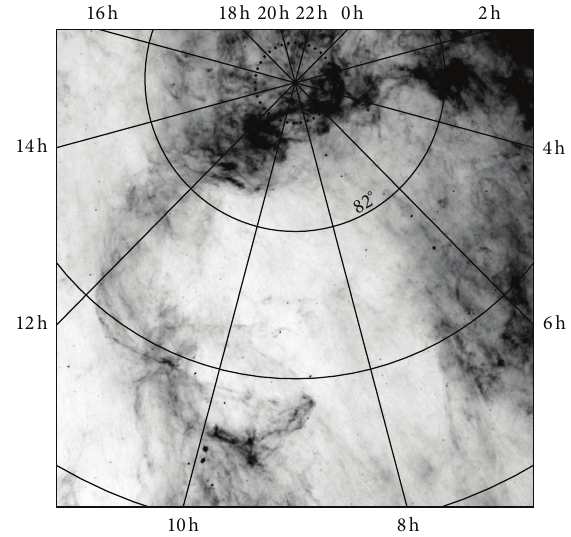
Figure 4: IRAS 100 𝜇 m map, showing the NCP Loop and the locations of the RING5M fields (near 𝛿 = 88 ∘ , top center). (Note that this figure is intended to illustrate the large-scale morphology of the NCP Loop—the location of the RING5M fields is indicated for reference